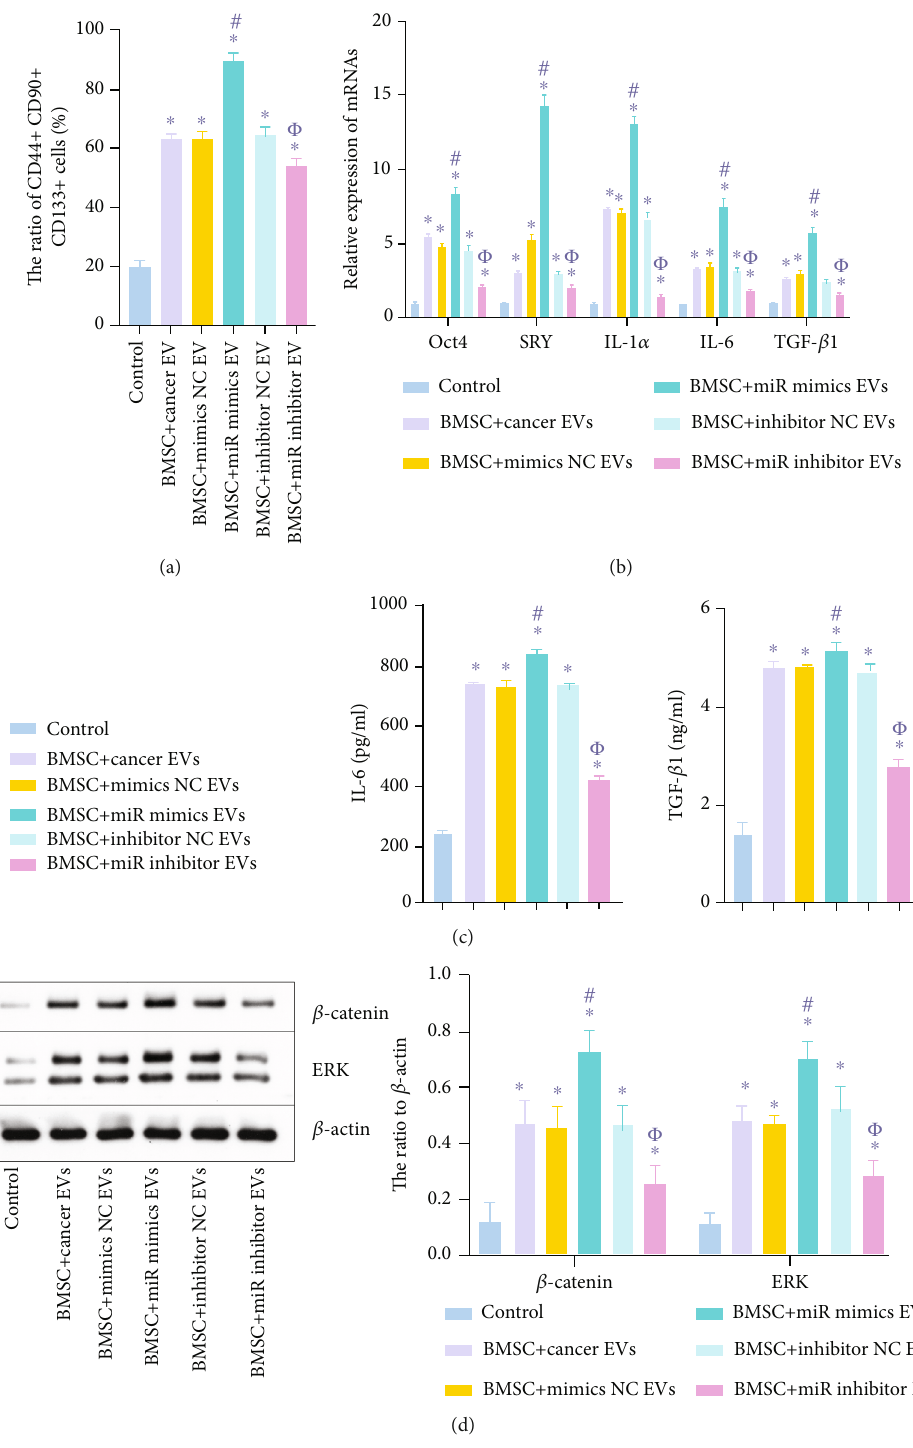
Figure 5: EVs with downregulated miR-126 signi fi cantly inhibited the di ff erentiation of BMSCs into cancer stem cells. BMSCs were divided into the following groups: control, BMSC+miR mimic EVs, BMSC+cancer EVs, BMSC+inhibitor NC EVs, BMSC+mimic NC EVs, and BMSC+miR inhibitor EVs. (a) BMSCs were cocultured with cancer EVs, mimic NC EVs, miR mimic EVs, inhibitor NC EVs, or miR inhibitor EVs. Then, the ratio of CD44+ CD90+ CD133+ cells in BMSCs was assessed by fl ow cytometry. (b) Oct4, SRY, IL-1 α , IL-6, and TGF- β 1 levels in BMSCs were assessed by RT-qPCR. (c) The content of IL-6 and TGF- β 1 in BMSC supernatants was investigated by ELISA. (d) The protein levels of β -catenin and ERK in BMSCs were tested by western blot. β -Actin was applied for normalization. ∗ P < 0 : 05 compared to the control. # P < 0 : 05 compared to BMSC+cancer EVs. Φ P < 0 : 05 compared to BMSC+inhibitor NC